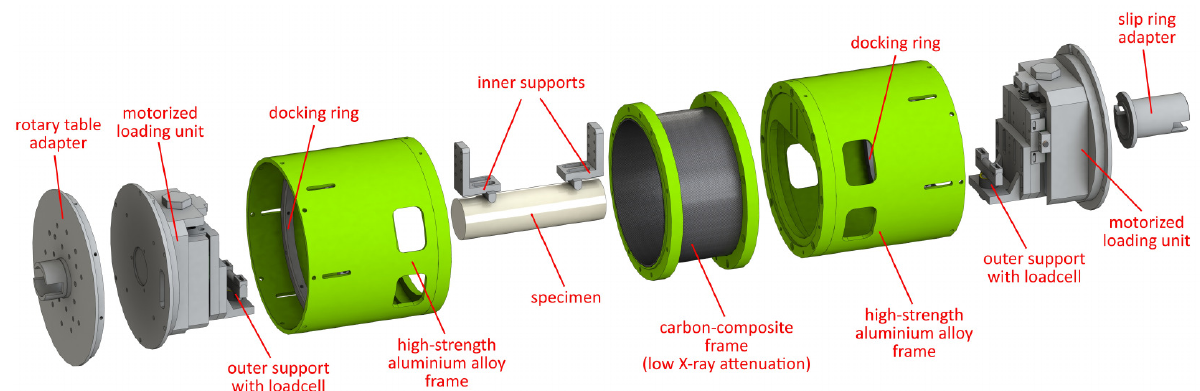
Figure 3. Components of the 4PB loading device